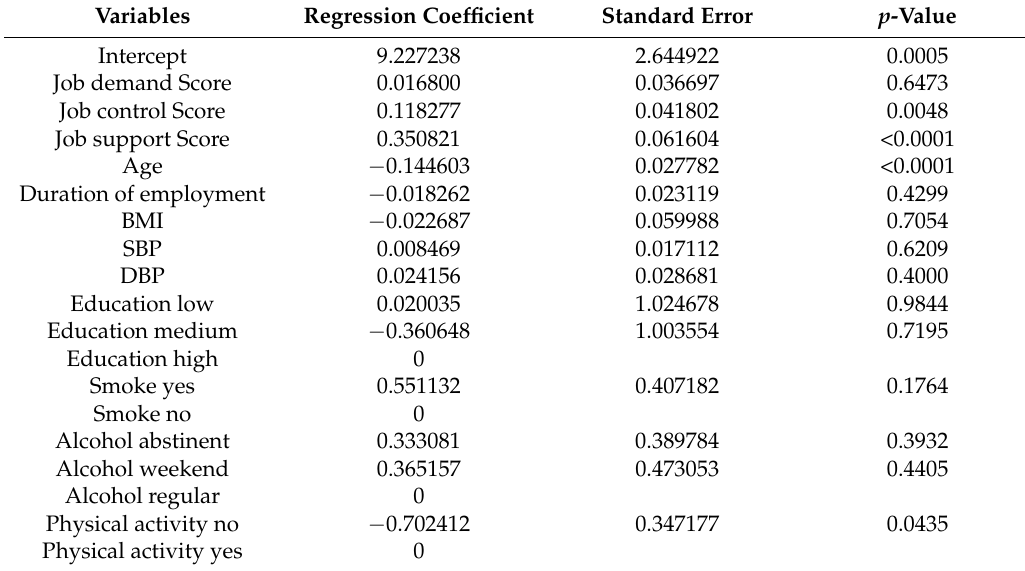
Table 7. Multiple linear regression predicting WHO-5 well-being (R 2 = 0.1661; adjusted R 2 = 0.1447). Independent variables: job demand score (continuous), job control score (continuous), job support score (continuous), age, duration of employment, BMI, SBP, DBP, educational level, alcohol intake, physical activity, and smoking